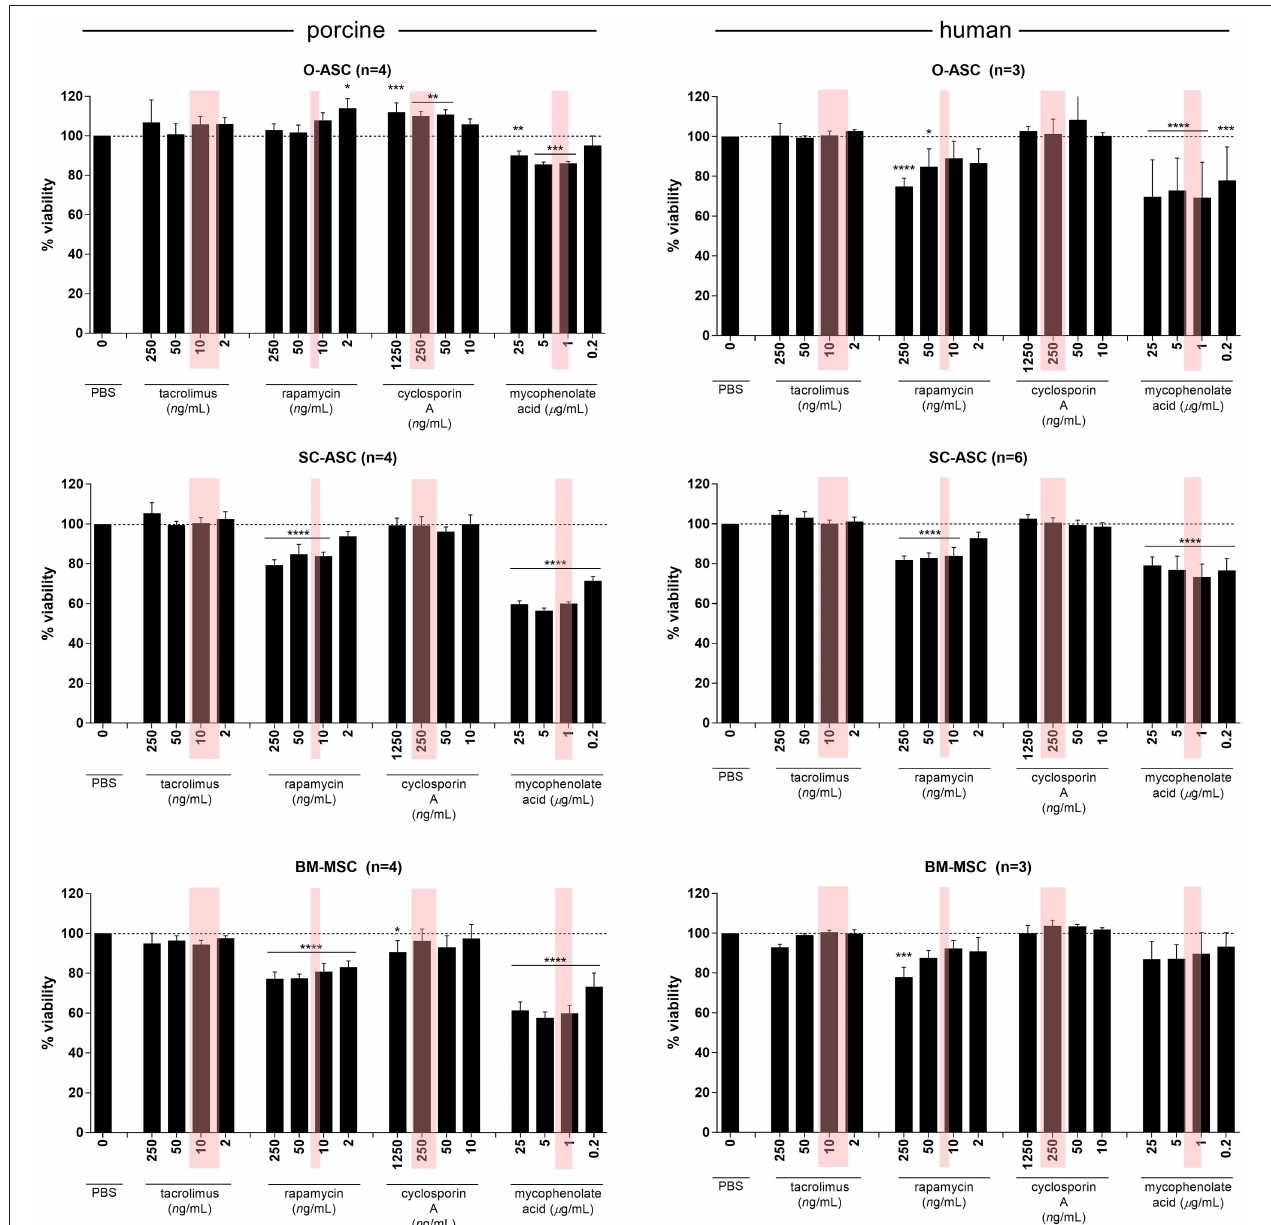
FIGURE 6 | Susceptibility of MSCs to immunosuppressive agents. The three cell lines (O-ASC, SC-ASC, and BM-MSC) were exposed to 4 different immunosuppressive agents commonly used in transplantation for 36h to assess the effect on cell proliferation using AlamarBlue. Expressed in % viable cells compared to control (no drug = vehicle + medium only). Error bars = SD. Red boxes indicate the approximate therapeutic ranges (Tacrolimus: 5–20ng/mL, Rapamycin 16–24ng/mL, Cyclosporin A 100–400ng/mL, Mycophenolic Acid 1-3.5 ug/L). Two-way ANOVA with Tukey post-test * p < 0.05, ** p < 0.01, *** p < 0.001, **** p < 0.0001 vs. control (PBS